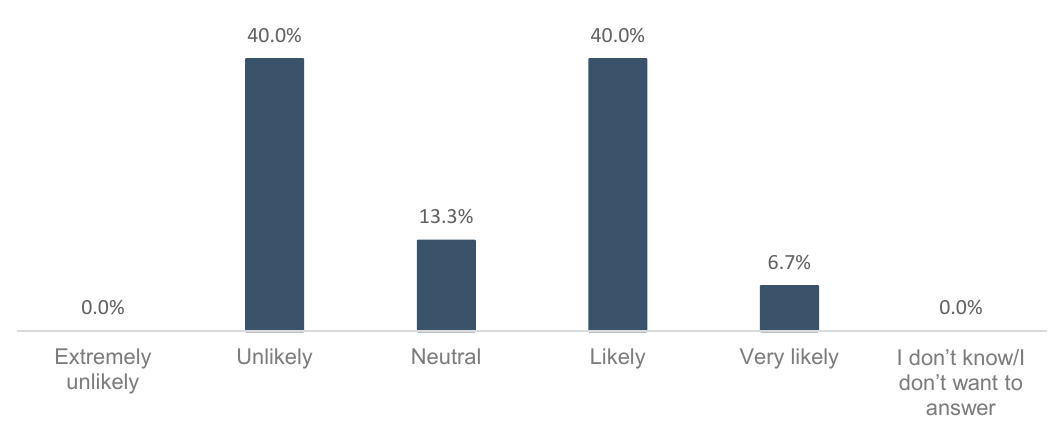
Figure 12. Likelihood to replace other marketplaces.